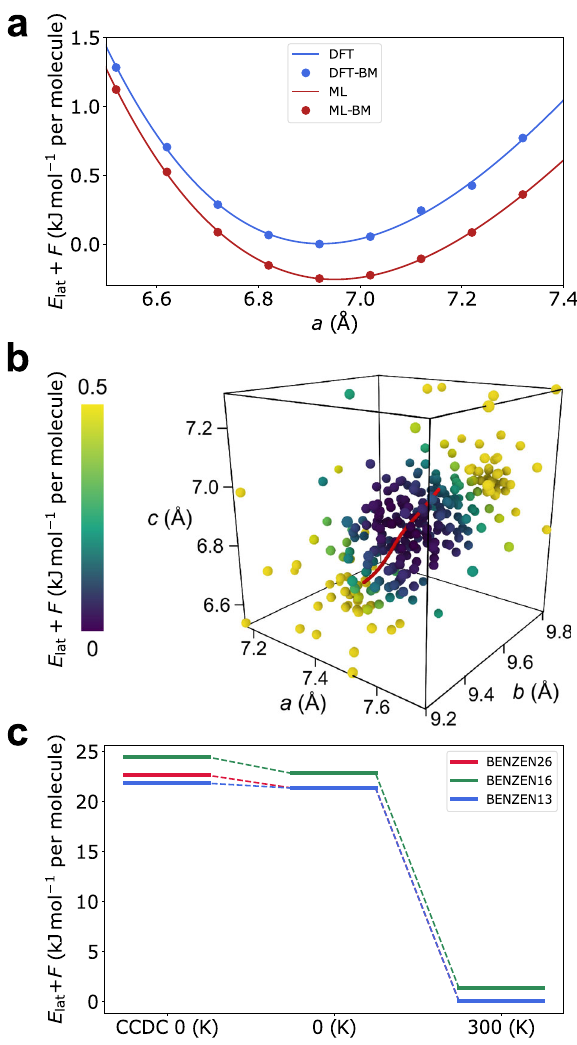
Fig. 5 Application of the developed framework to predict the thermal lattice expansion. a Predicted (red) and calculated (blue, DFT) free energies as a function of one lattice parameter of the BENZEN11 crystal at 200 K. Solid lines correspond to a Birch- Murnaghan fi t. b 3D visualization, in lattice parameter space ( a , b , c ), of the free energy prediction including lattice expansion of the anthracene crystal at 200 K, with 300 different combinations of perturbed lattice parameters. The red line indicates the observed change in the lattice parameters when increasing the temperature from 0 to 300 K. c Relative predicted free energies of benzene crystal structures when considering fi xed lattice constants (taken from CCDC), and when considering lattice expansion at 0 and at 300